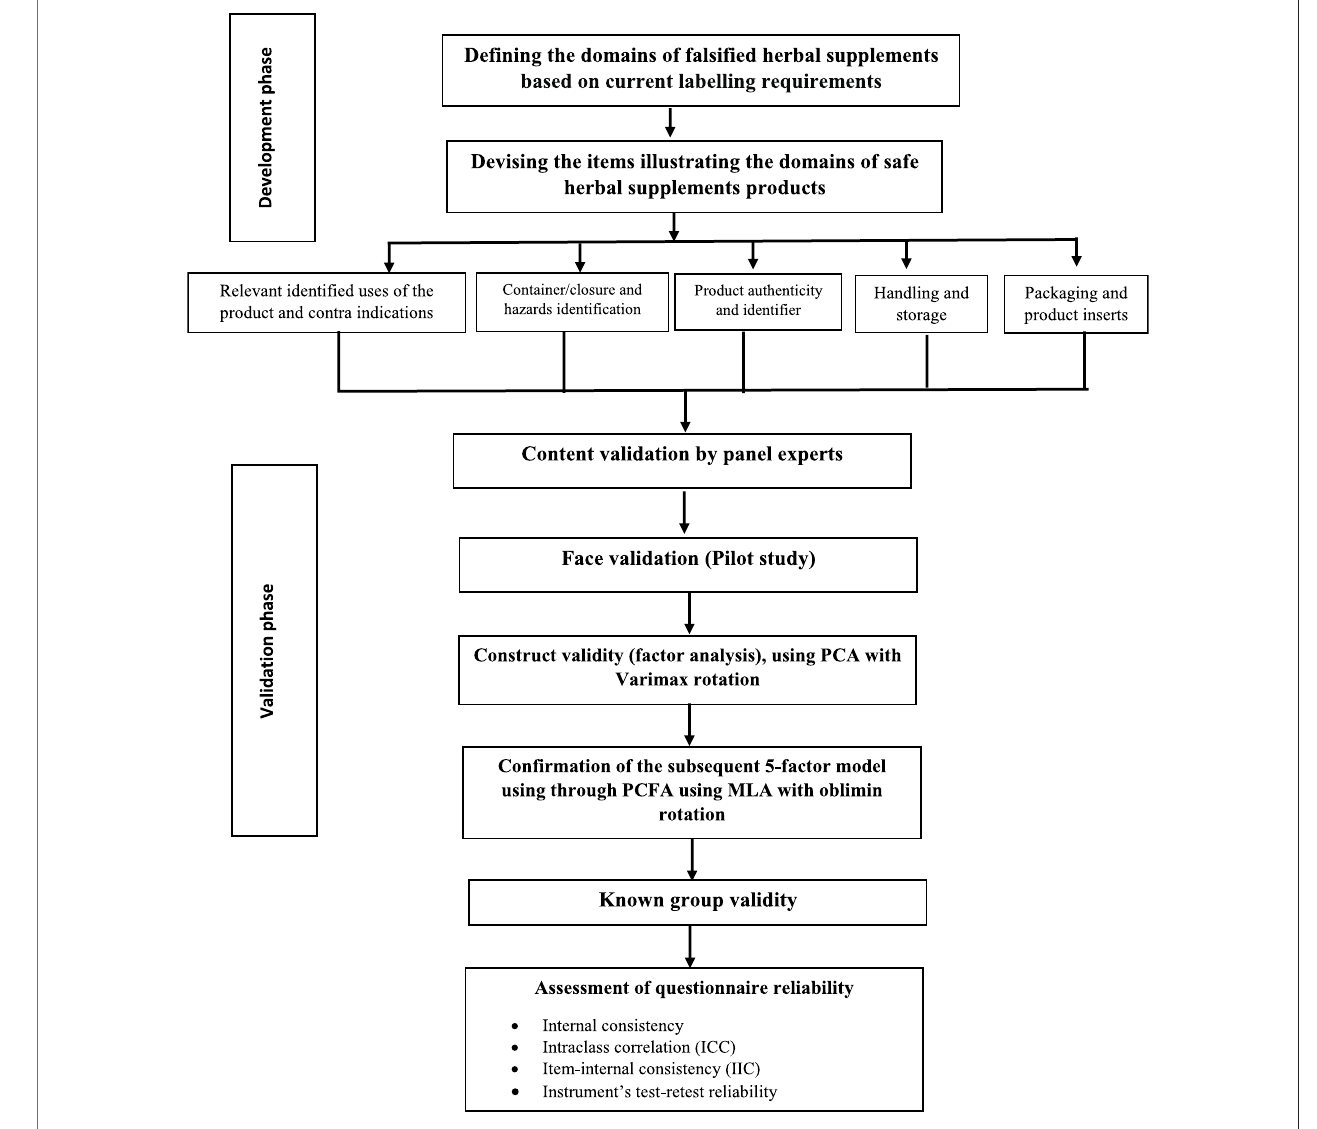
FIGURE 1 | Flow chart for development and validation